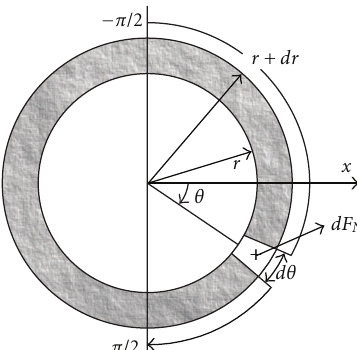
Figure 4: Di ff erential area ( d a = r d r d θ ) on surface S 2 and the normal component of contact force (normal to the reference mean plane).